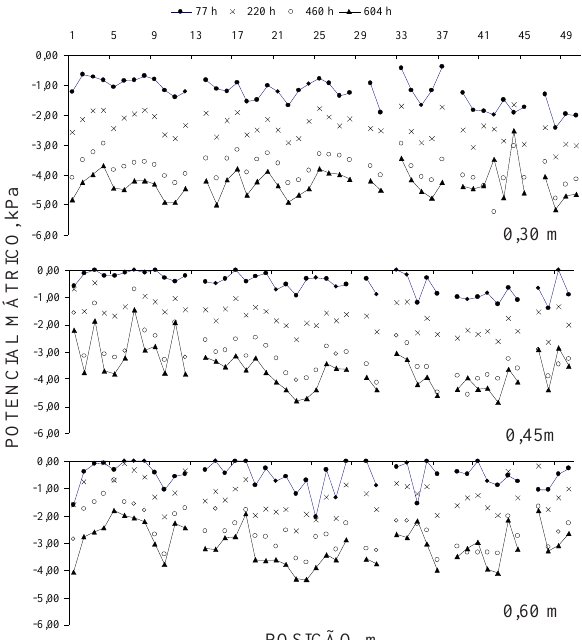
Figura 3. Variabilidade do potencial mátrico (kPa), segundo uma transeção de 50 pontos espaçados de um metro, em três profundidades e quatro tempos de amostragem. A linha interrompida indica os cinco pontos de medida que foram